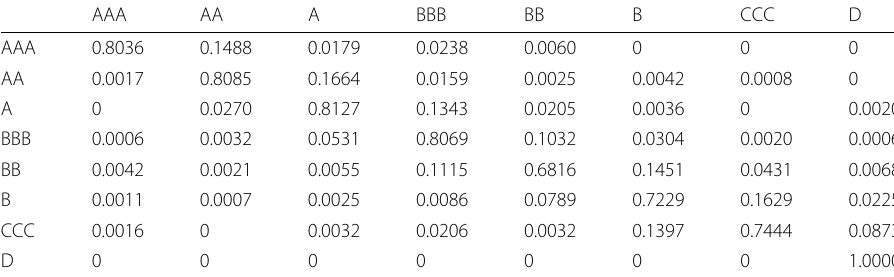
Table 2 Two step transition probability matrix for Service Sector